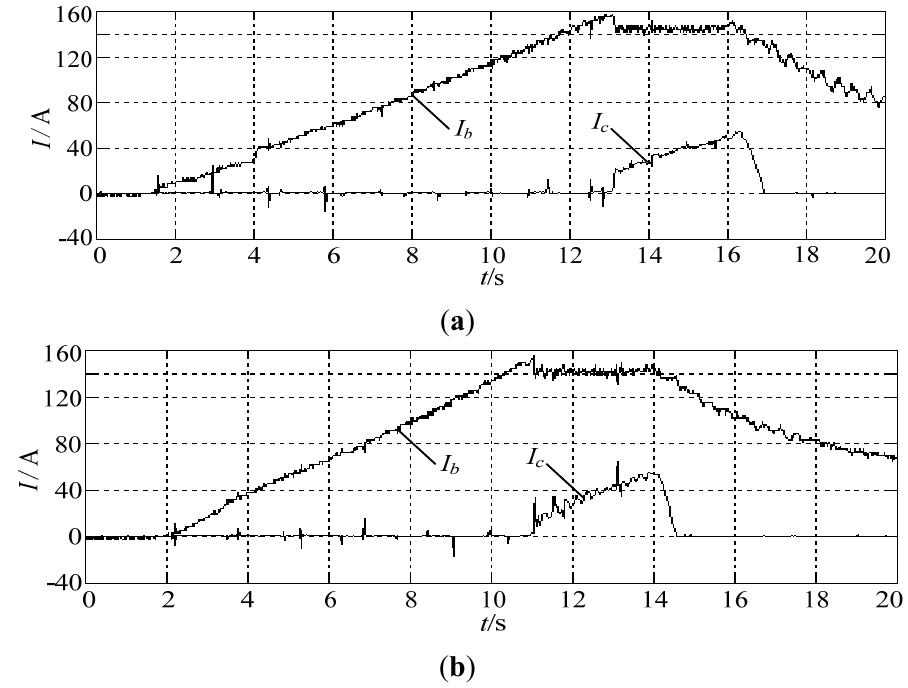
Figure 8. Discharging current of the batteries and ultra-capacitors under motoring operation. ( a ) PID controller; ( b ) H ∞